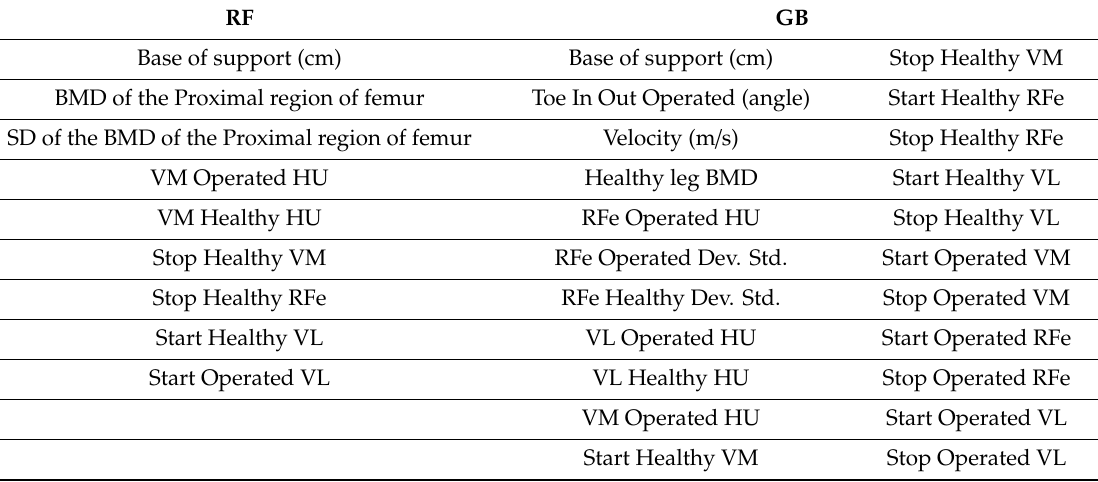
Table 2. Features chosen by Wrapper for the classification